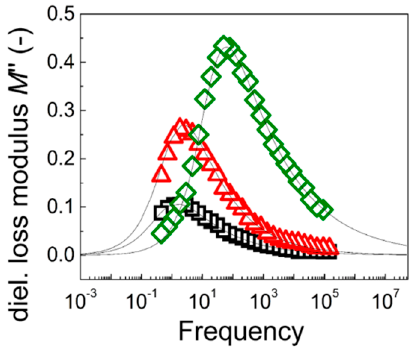
Figure 9. Dielectric loss moduli, M” , dependence on frequency for 5 wt.% ER fluids consisting of unmodified GO ( (cid:3) ), GO-PHEMATMS-1 ( (cid:52) ), and GO-PHEMATMS-2 ( ) particles in silicone oil M200.